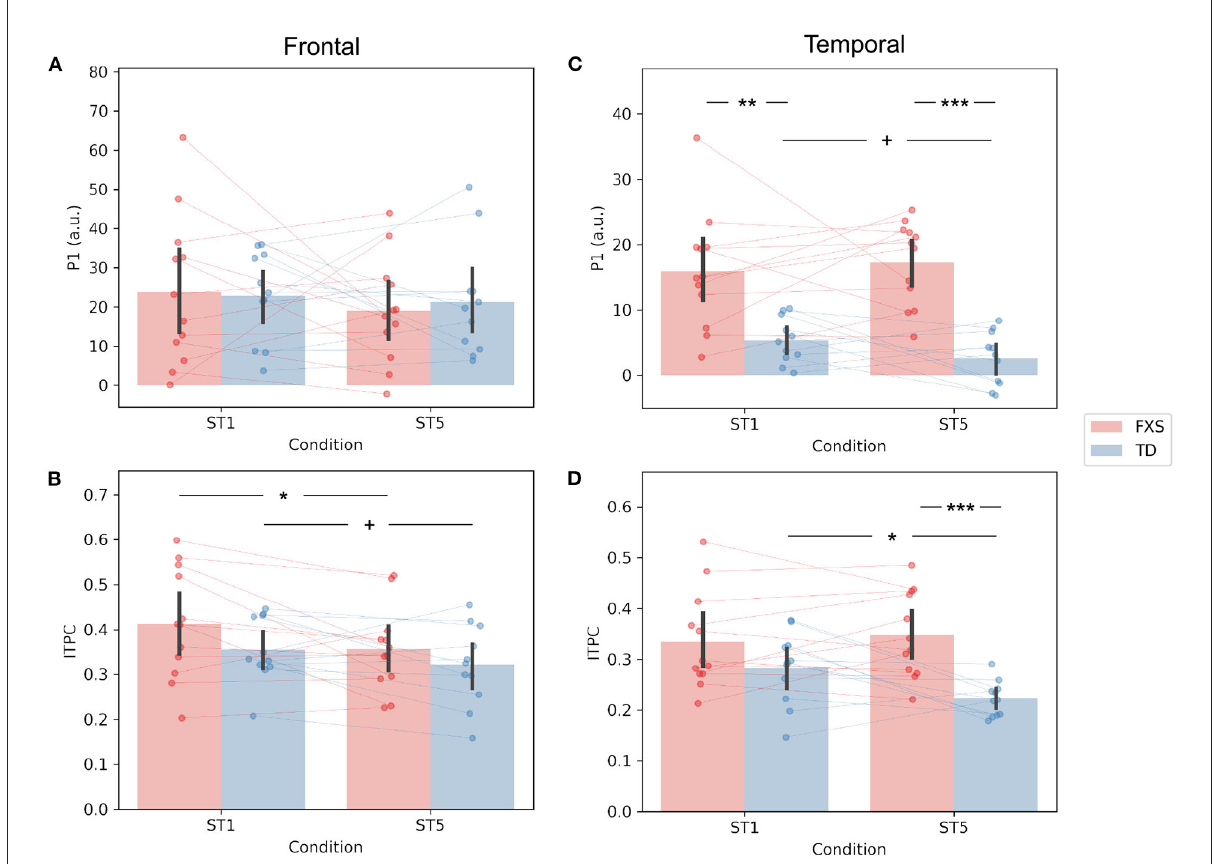
FIGURE4 Comparison of (A) frontal P1, (B) frontal ITPC, (C) temporal P1, and (D) temporal ITPC between conditions and groups. + p < 0.1; * p < 0.05; ** p < 0.01; *** p <